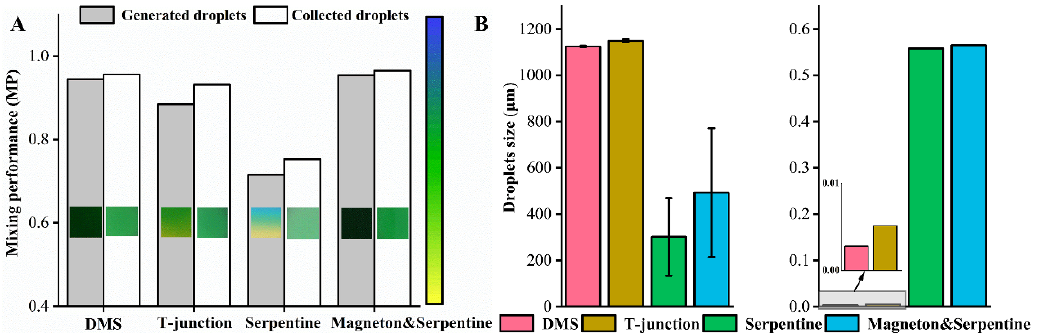
Figure 8. ( A ) Mixing performance of different microfluidic devices. ( B ) Droplets size and coefficient of variation of different microfluidic devices.